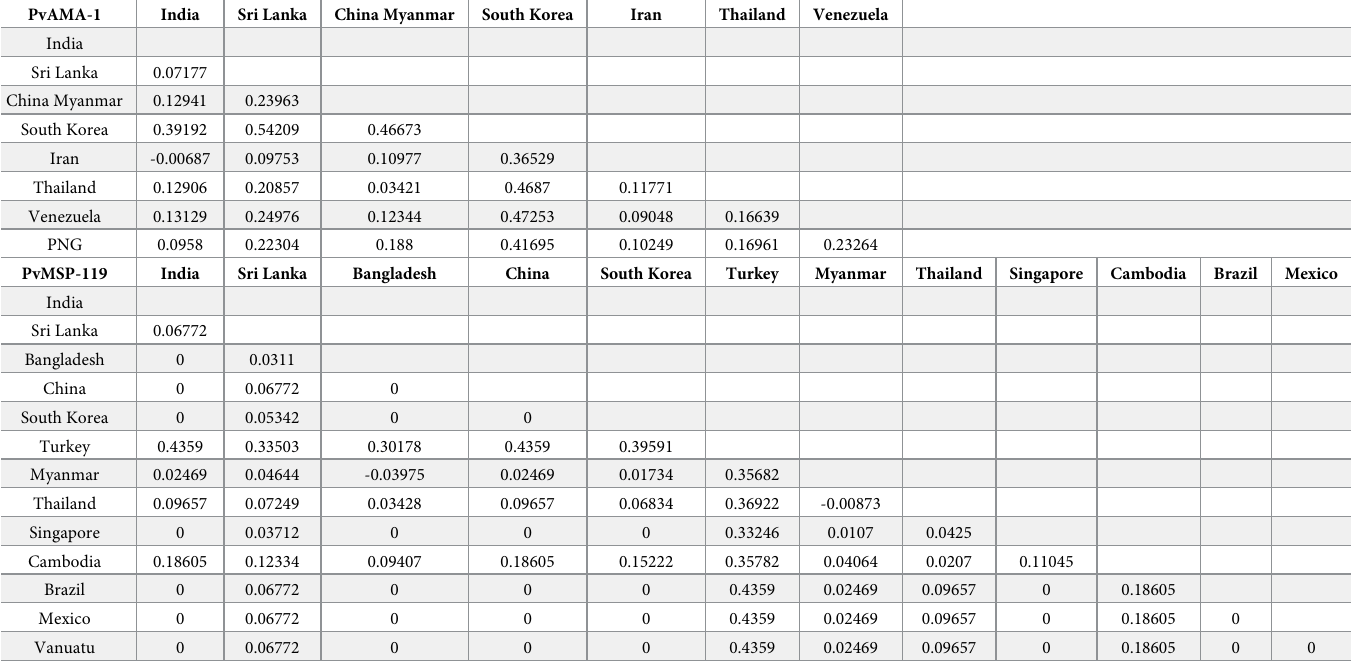
between the Indian and South Korean populations. A high F value (0.36–0.54) was also ST detected for South Korea and other population. Moderate F values (0.07–0.13) were detected ST among the India, China Myanmar, Thailand, Venezuela, PNG, and Sri Lanka populations. A negative F value (-0.00687) was observed between Indian and Iranian isolates, showing a ST high degree of genetic similarity between these two populations. populations were evaluated (Table 3). F F ST values of the thirteen worldwide Pvmsp1 ST 19 values of India, Bangladesh, China, South Korea, Singapore, Brazil, Mexico, and Vanuatu approached zero, indicating a high degree of genetic similarity. Turkey showed a high F ST value (0.33–0.43) when compared to India, China, Myanmar, Thailand, Singapore, Cambodia, Brazil, Mexico and Vanuatu populations, which represents a high degree of genetic distance. Moderate F values (0.02–0.18) were detected when the Indian population was compared ST with population from Cambodia, Thailand, and Myanmar.